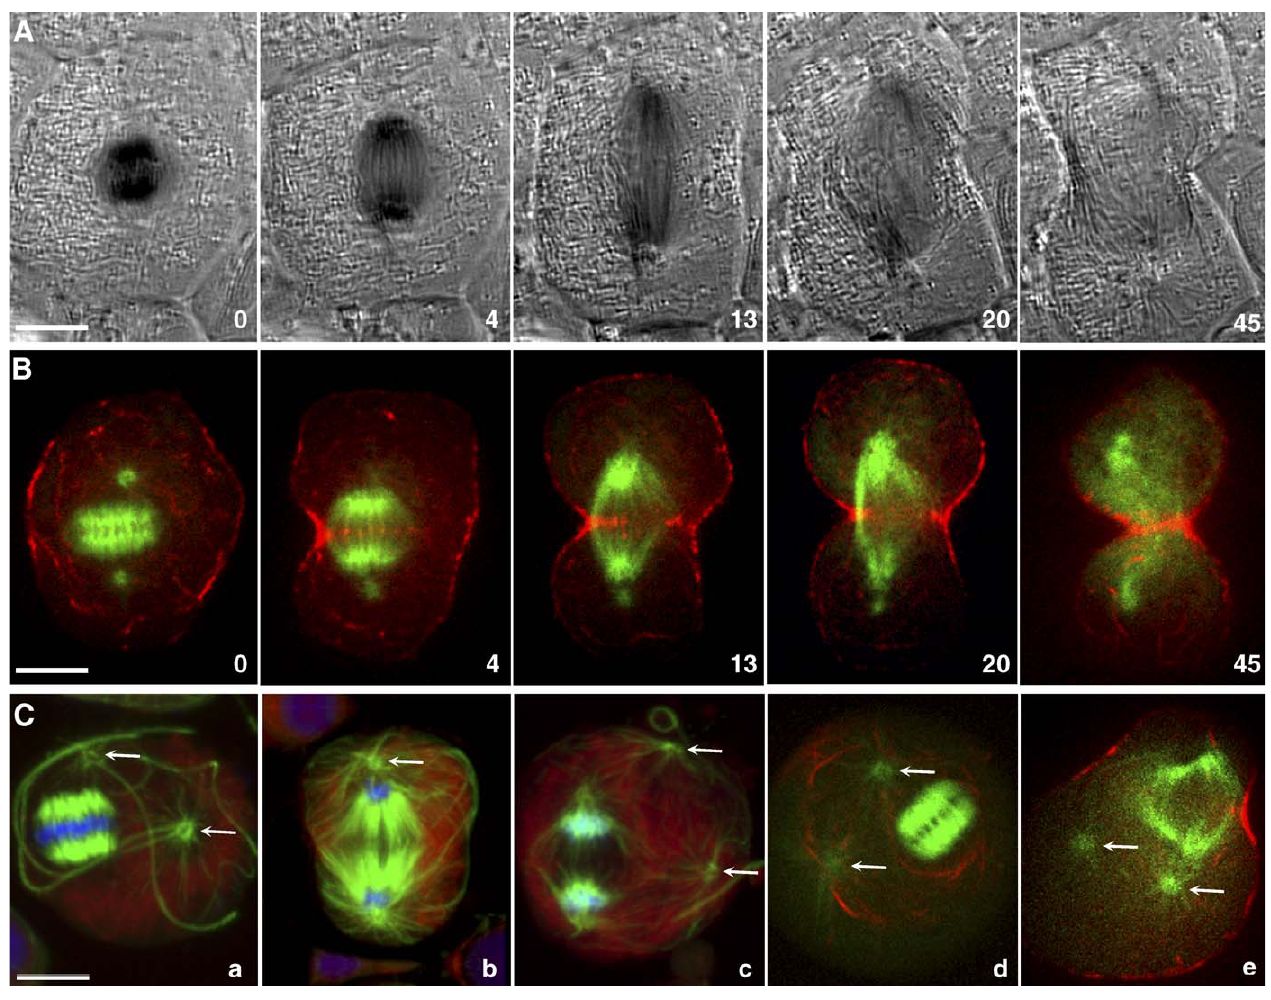
Figure 1. Cytokinesis of Silkworm Spermatocytes (A) Polarization micrograph of a dividing spermatocyte. (B) Confocal micrographs of a spermatocyte microinjected with rhodamine tubulin (microtubules false colored green), and low-level Alexa Fluor 488 phalloidin (actin false colored red). Actin aggregates appeared at the equatorial microtubule plus ends during early anaphase (0–20), then fused into a contractile ring that bisected the cell (4–45). (C) Astral flagella, as well as naturally, asymmetrically positioned asters, were visible in dividing spermatocytes. Astral flagella were visible only in fixed, immunostained cells (a–c). Astral microtubules were prominent in fixed anaphase spermatocytes (e.g., b). One aster was loosely attached to the spindle (arrow). Occasionally, the asters (arrows) in fixed (a and c) and live (d and e) spermatocytes (arrows) were naturally positioned on the same side of the spindle. a and d, metaphase; b, c and e. anaphase. Fixed cells were double-immunolabeled for actin and tubulin; live cells were labeled as in (B). Time in min. Time 0 in (A and B), anaphase onset. Bars, 10 l m.